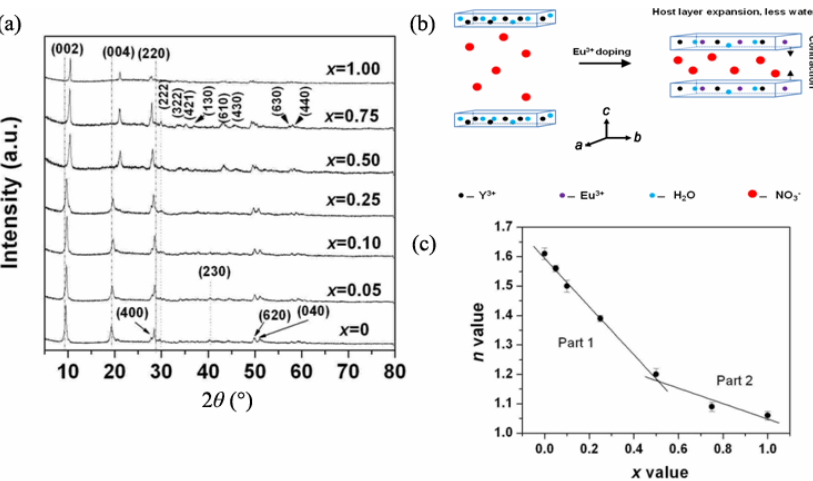
Fig. 3 (a) XRD patterns and (c) the hydration number n of (Y 1  x Eu x ) 2 (OH) 5 NO 3 · n H 2 O as a function of the Eu content ( x value). (b) Structure changes induced by Eu 3+ doping. Reproduced with permission from Ref. [7], © American Chemical Society